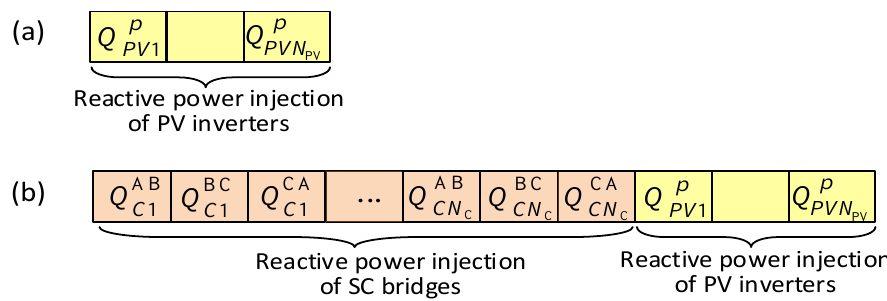
Figure 3. Considered particle of decision variables to be determined by MPSO in: ( a ) Stage 2; ( b ) Stage 3.